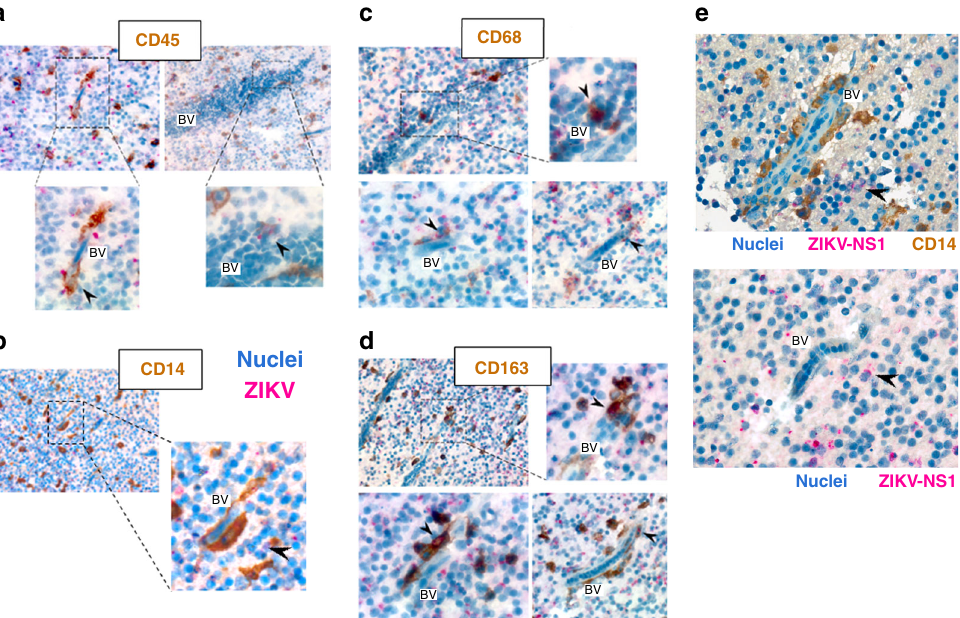
Fig. 1 Monocyte-derived cells are infected by ZIKV in a human fetus with microcephaly. a – e Immunohistochemical staining was performed on human fetal brain tissues from a PCR-con fi rmed case of congenital ZIKV (gestational age 22 weeks). All slides were counterstained in Mayer ’ s Hematoxylin and blued in Lithium carbonate. The tissue slices were stained for ZIKV – NS1 in combination with a CD45 (left panel: 63×, right panel: 40×), b CD14 (20×), c CD68 (upper panel: 63×, lower left panel: 100×, and lower right panel: 40×), or d CD163 (upper panel: 40×, lower left panel: 100×, and lower right panel: 63×). e The endothelial cells of slices from the same tissue appear morphologically intact and were never found positive for ZIKV – NS1 staining. The black arrowheads indicate ZIKV-infected cells. BV blood